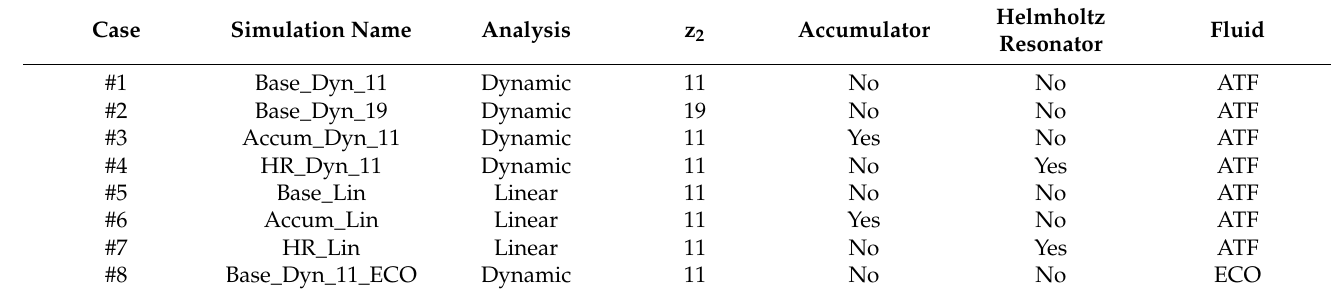
Table 4. Simulated cases.